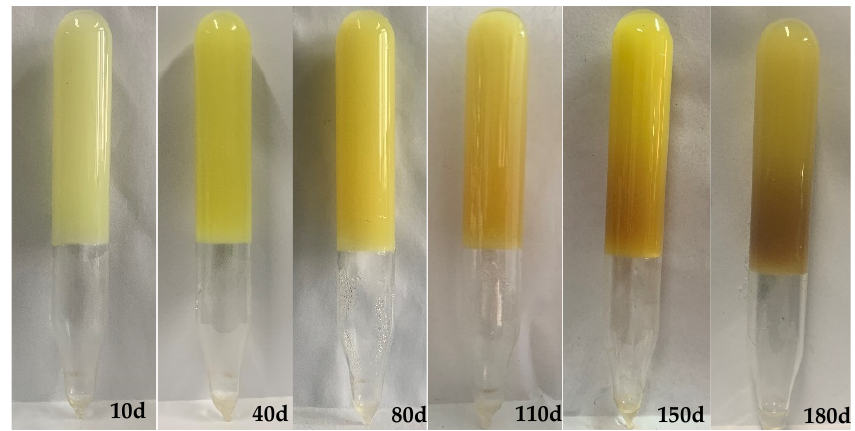
Figure 6. Stability of a gel strengthened by nanoparticles at 70 °C for different time. To elucidate the mechanism by which the nanoparticles stabilized the gel, DSC meas- urements were used to determine the content of the different types of water in gels aged at 70 °C for 7 days in situ (Figure 7).